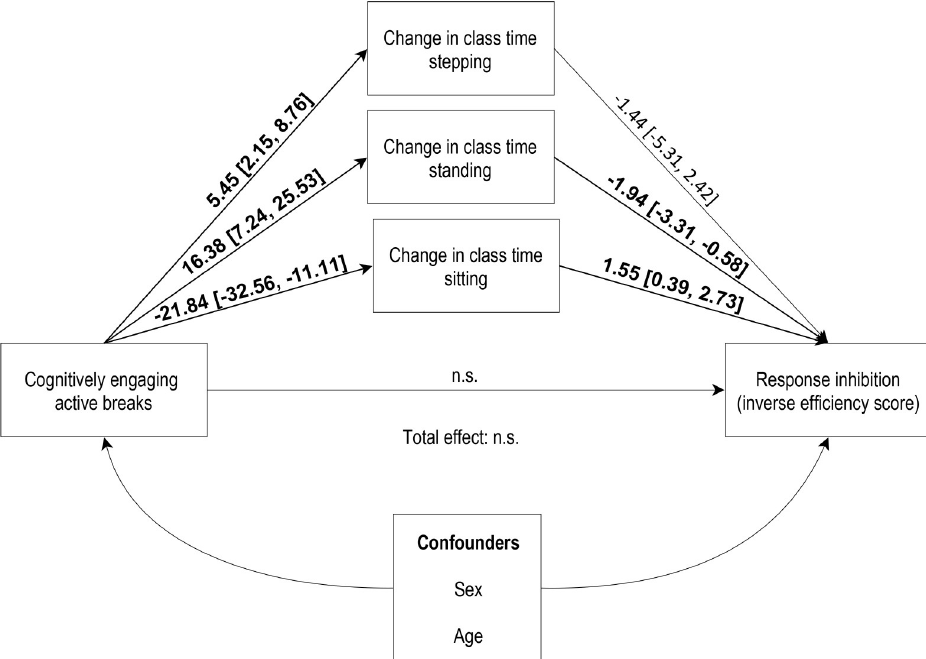
Fig 5. Mediated effects of cognitively engaging active breaks on response inhibition inverse efficiency score via changes in sitting, standing, and stepping time. Natural indirect effects (NIE) of cognitively engaging active breaks on response inhibition. Results are presented as B (95% CI). Significant effects in bold. Natural direct effects (NDE) and total effects were non-significant (n.s.).